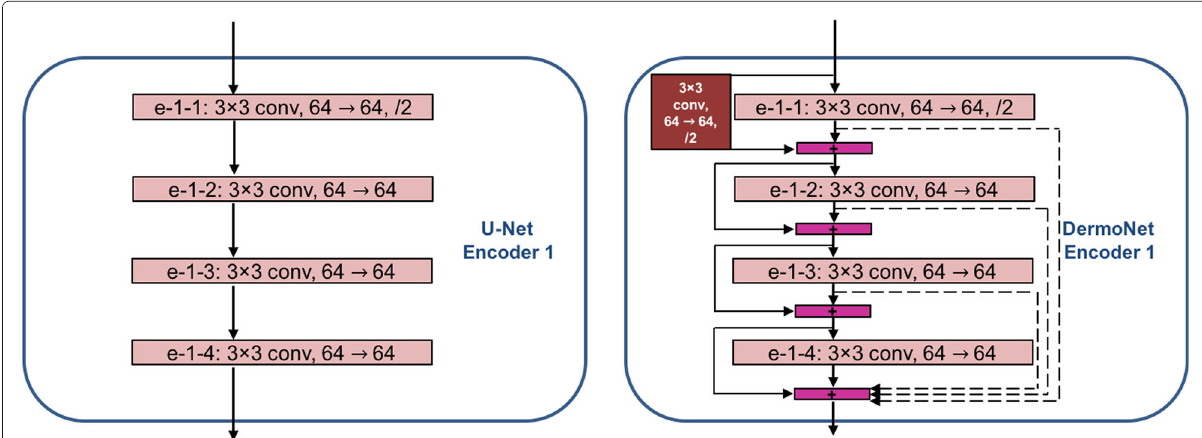
Fig. 2 Encoder difference between U-Net and